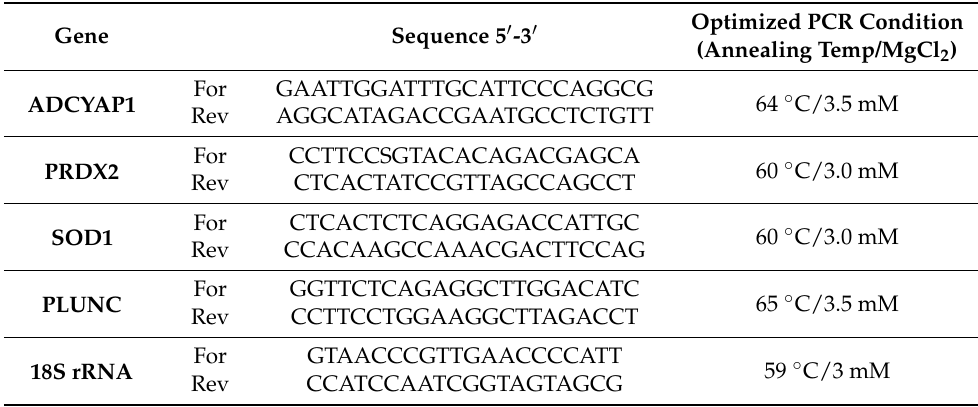
Table 2. Oligonucleotide primers used for qRT-PCR